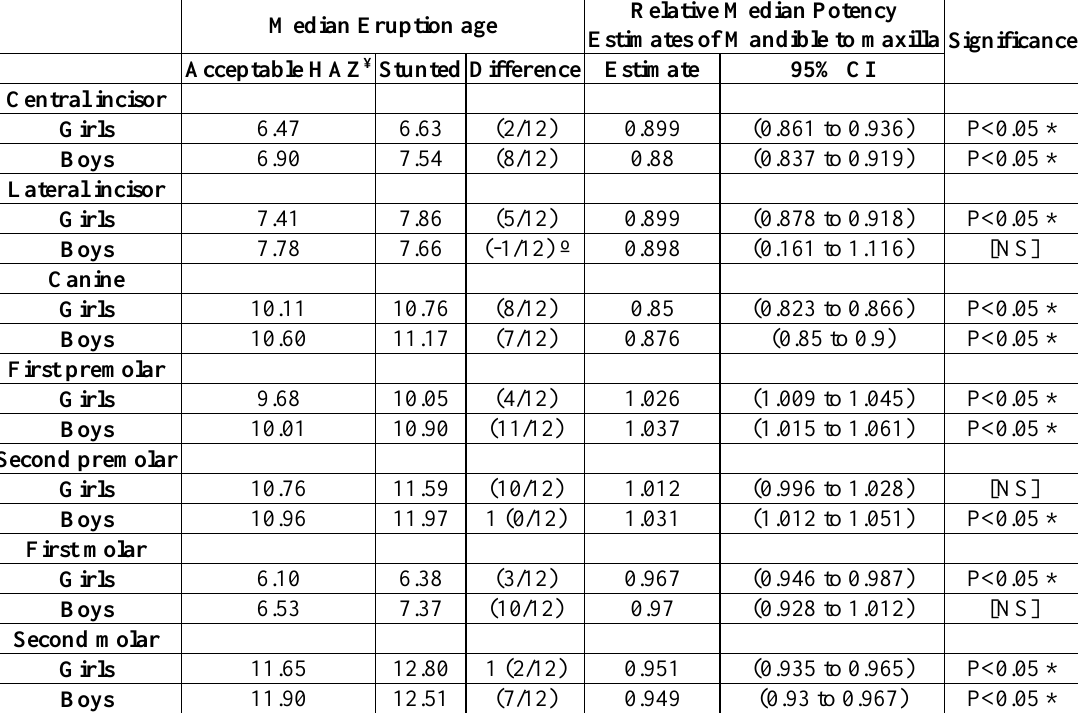
Table 5: Difference in median eruption time between stunted and acceptable height for age with relative median potency of mandible to maxilla according to gender Relative Median Potency Median Eruption age Estimates of Mandible to maxilla Significance Acceptable HAZ ¥ Stunted Difference